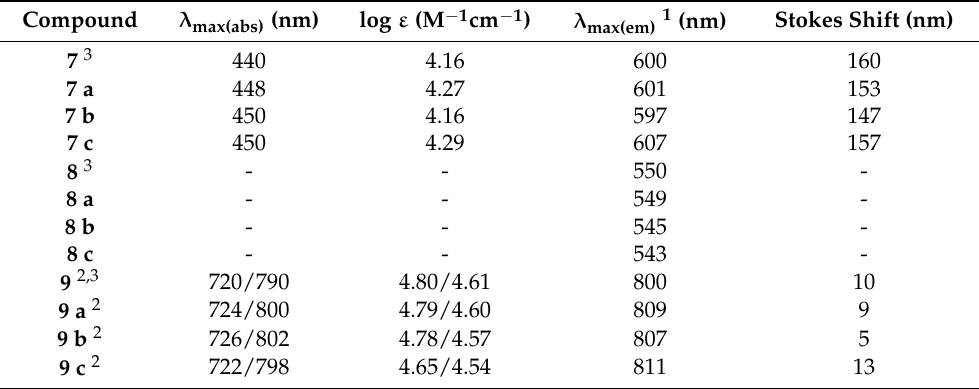
Table 2. Summary of the photophysical properties of the MIUs 7-9 and the corresponding hybrid multimodal bioconjugates 7 a-c , 8 a-c and 9 a-c . Values were determined in PBS at a concentration of 1 × 10 − 5 mol × L − 1 .) Compound λ max(abs)